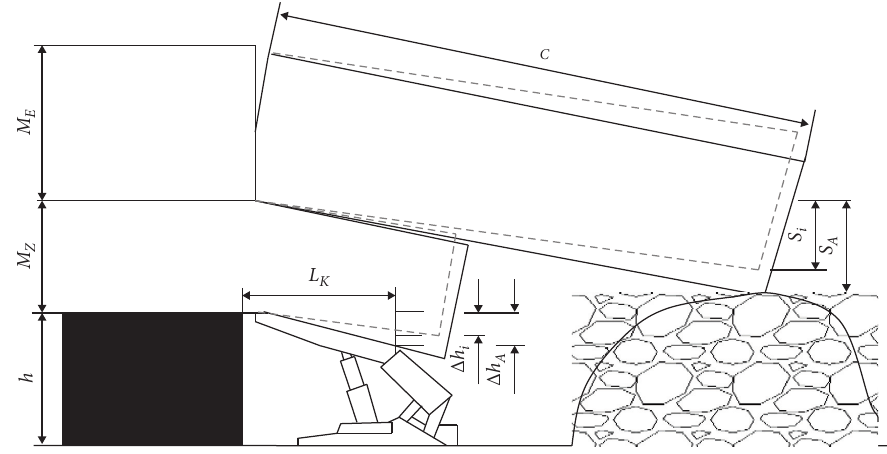
Figure 10: Schematic diagram of the roof control position in the mining face. Table 6: The roof control level corresponding to 5 working resistances of support. Resistance of support